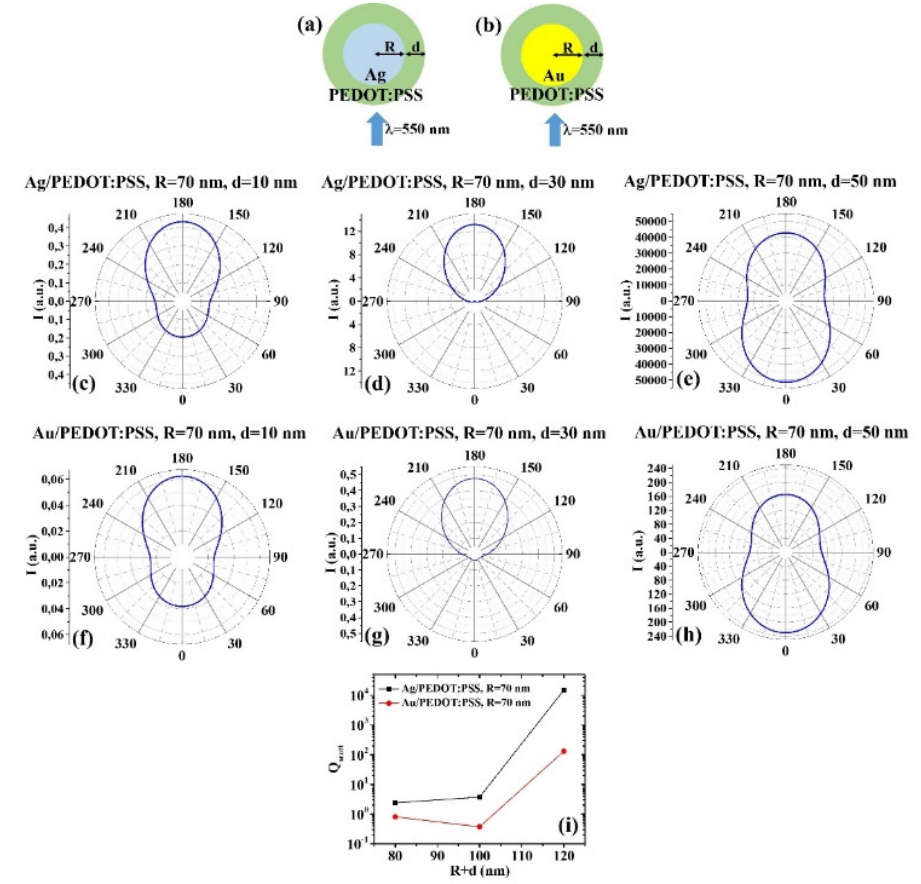
Figure 10. ( a , b ) Scheme of the structure of the simulated Ag/PEDOT:PSS ( a ) and Au/PEDOT:PSS ( b ) core–shell spherical particle with core radius R and shell width d and electromagnetic radiation of wavelength λ = 550 nm impinging on the particle from 0 ◦ . ( c – e ) Calculated polar diagrams for the intensity of the scattered light from the Ag/PEDOT:PSS core–shell spherical particle fixing the Ag core radius R to 70 nm and increasing the PEDOT:PSS shell width from 10 nm to 50 nm. ( f – h ) Calculated polar diagrams for the intensity of the scattered light from the Au/PEDOT:PSS core–shell spherical particle fixing the Au core radius R to 70 nm and increasing the PEDOT:PSS shell width from 10 nm to 50 nm. ( i ) Calculated scattering efficiency for the light (wavelength λ = 550 nm) scattering process of the Ag/PEDOT:PSS (black dots) and Au/PEDOT:PSS (red dots) core–shell spherical particles fixing the core radius to R = 70 nm and increasing the PEDOT:PSS shell width d from 10 nm to 50